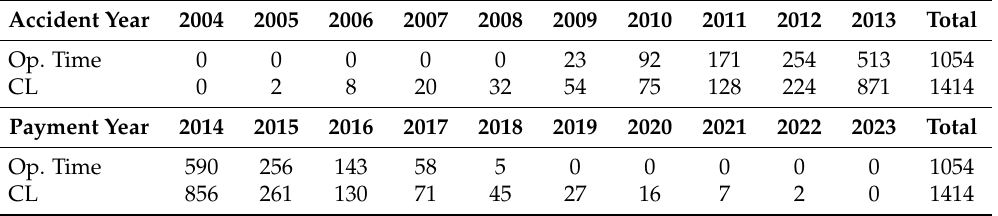
Figure 3. Estimated components of hazard rate of the payment delay T : ( a ) operational time estimate ˆ ϕ ( t ) with optimal bandwidths; ( b ) baseline hazard estimate ˆ α 0 ( T − t ) of payment delay (in forward time) with optimal bandwidths. Table 1. Estimated number of outstanding claims through hazard with operational time (op. time) and quarterly chain-ladder (CL) by accident year and payment